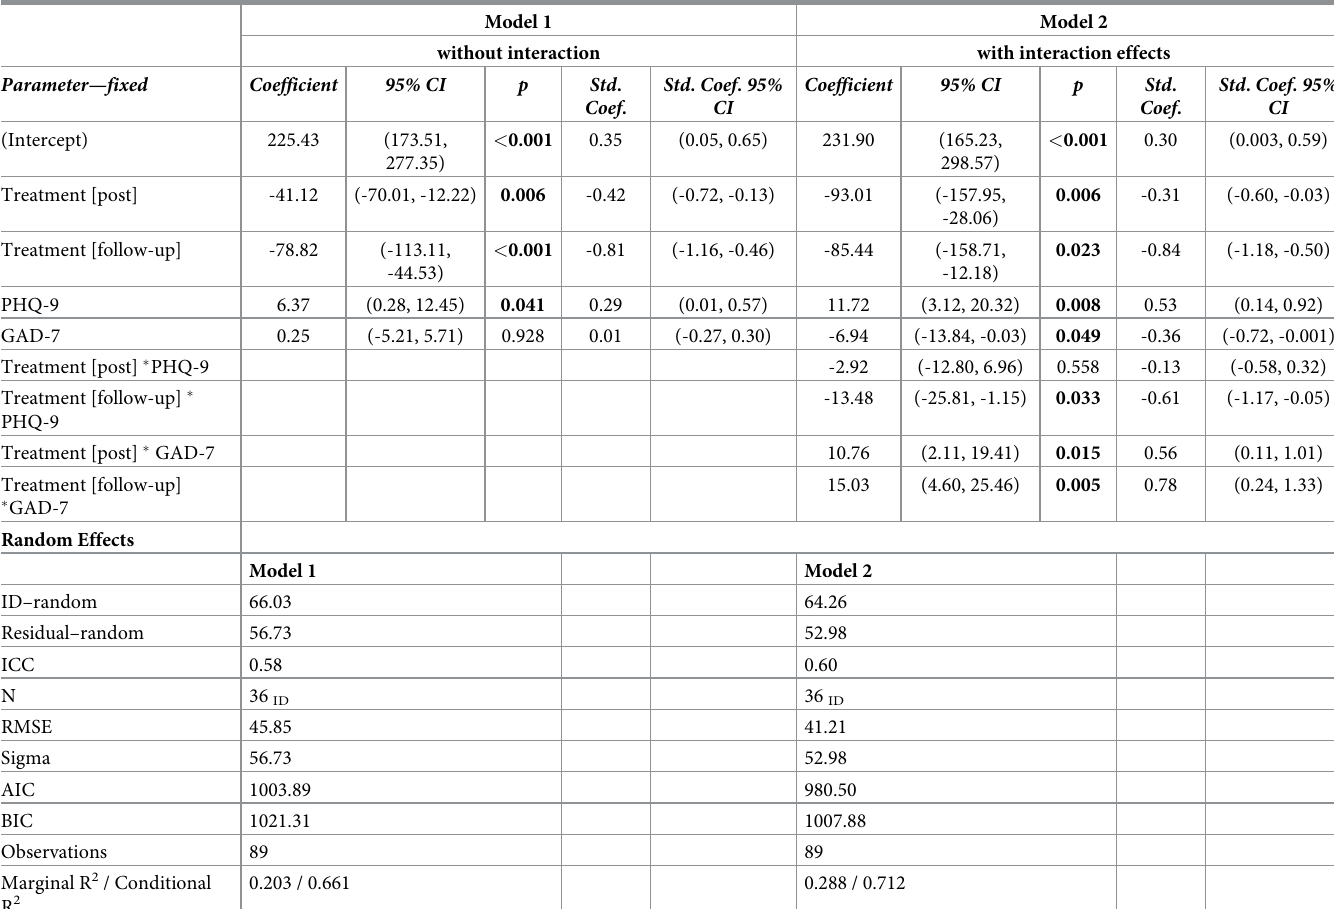
Table 3. Comparing AMT treatment effect on IBS severity score post-AMT and at 12 month follow-up with interaction effects of depression and anxiety with treat- ment on IBS severity scores in linear mixed effects